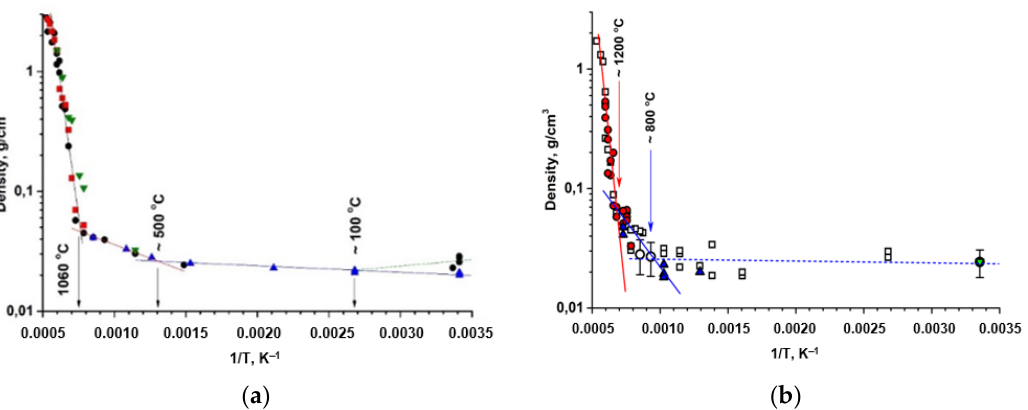
Figure 6. Evolution of the sample volume density as a function of the annealing temperature. The different markers indicated the different series of measurements. The characteristic transition temperatures are marked on the graphs: ( a ) PMOA samples: ~100 ÷ 500 ◦ C—desorption and dehydration; 550 ÷ 1000 ◦ C—the surface diffusion activation range; ≥ 1060 ◦ C—sintering region [11]. ( b ) PMOA-M samples: ~150 ÷ 750 ◦ C—desorption and dehydration; 750 ÷ 1150 ◦ C—the surface diffusion activation range; ≥ 1200 ◦ C—sintering